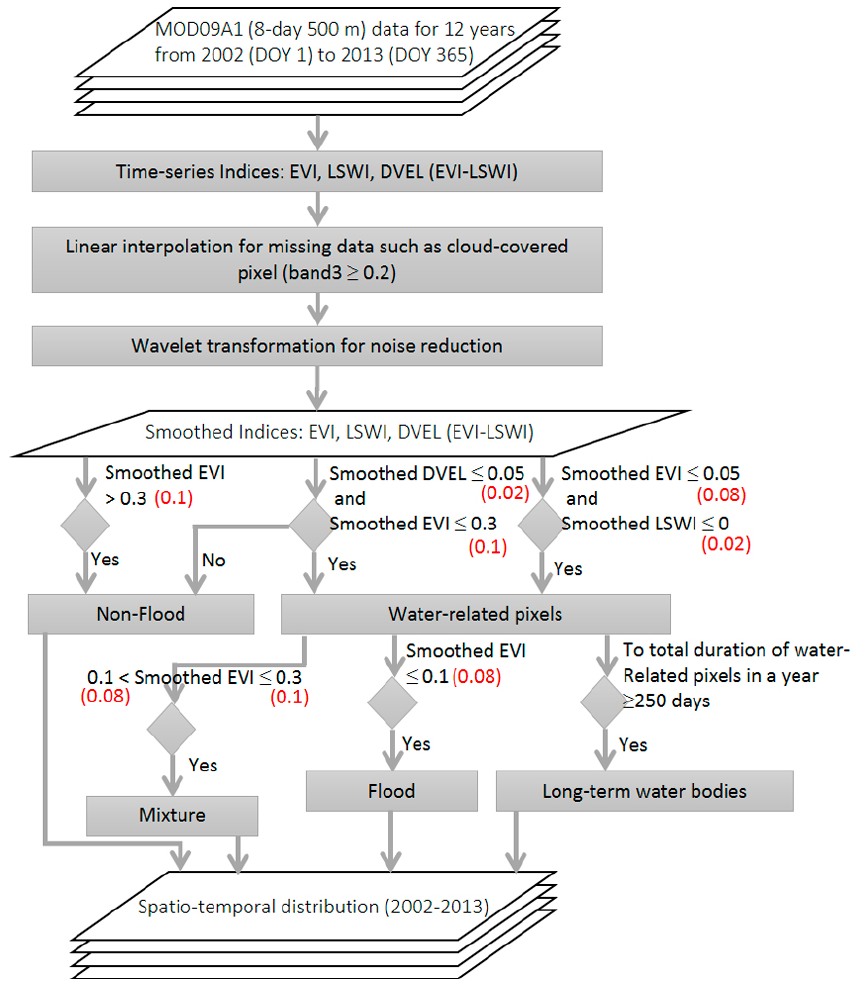
Figure 2. Flow chart of the mechanisms of the Wavelet-based Filter for detecting the spatio-temporal changes in Flood Inundation (WFFI), developed by Sakamoto et al. [16]. Red fonts indicate modified threshold values in this study.